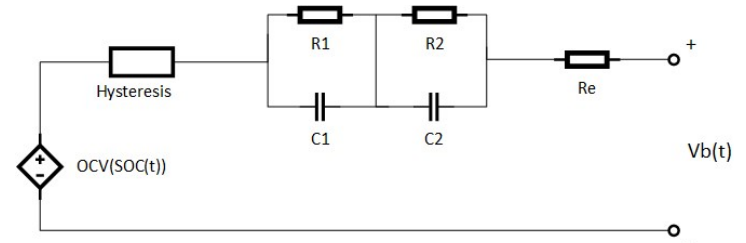
Figure 2. Equivalent circuit model.